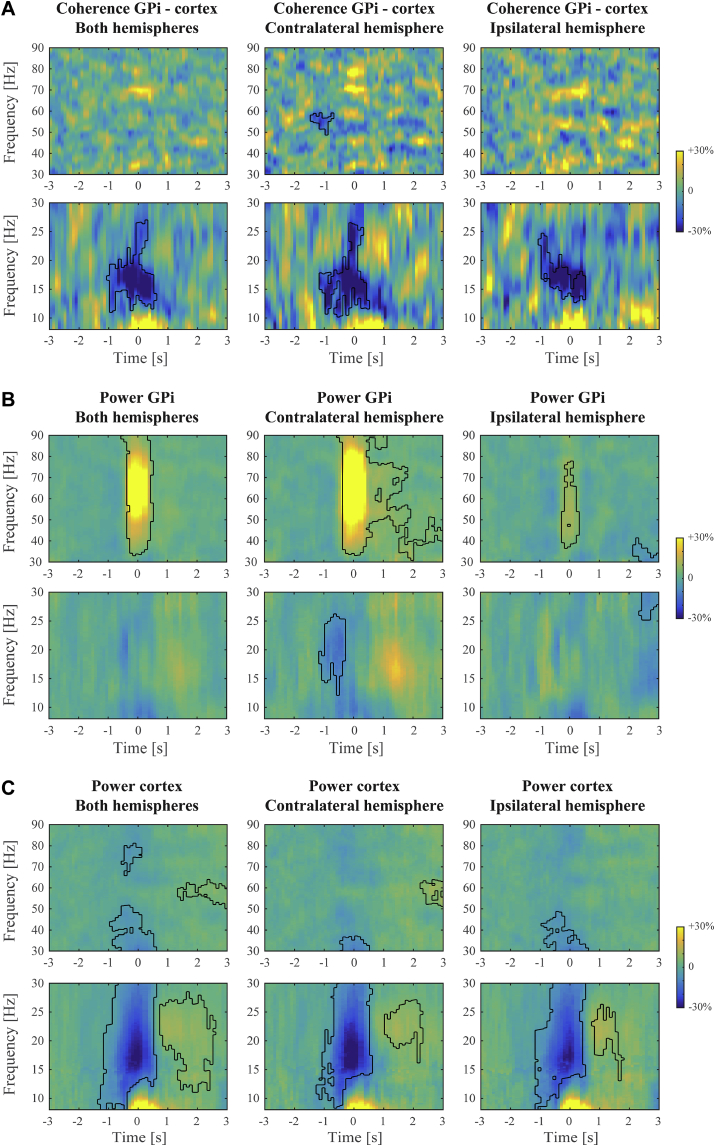
Movement-related coherence and power spectra. Shown are the grand-average changes in A) cortico-pallidal coherence; B) pallidal power; and C) cortical power, expressed as a percentage of the average in the -3 to -1s pre-movement time window. Left and right hand conditions were combined to form contralateral and ipsilateral hemispheres with respect to the moving hand. Significant clusters under FDR-corrected cluster-level p < .05 are outlined with black contour lines. For better visibility, we show beta and gamma frequency ranges in different panels but note that we performed the FDR correction on the entire spectrum. No significant beta coherence clusters were detected when contrasting ipsilateral and contralateral spectra.